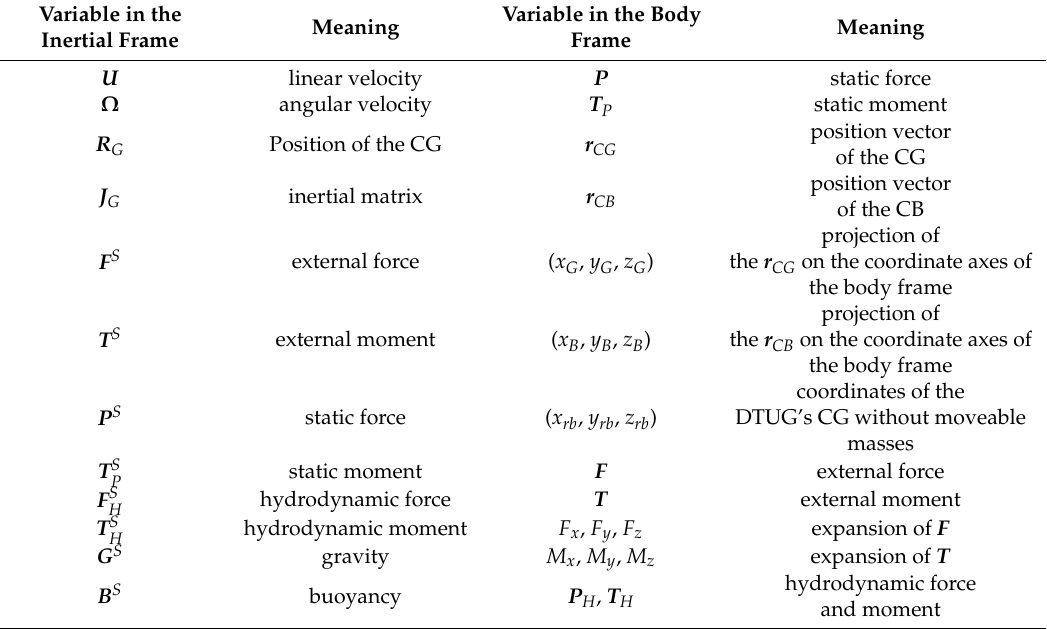
Table 2. The meanings of the variables mentioned in the dynamic